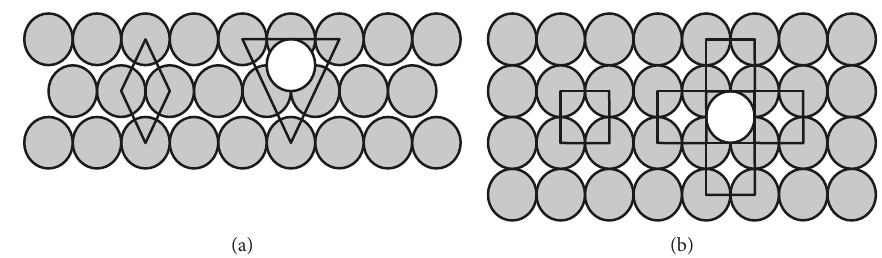
Figure 1: (a) Sulfur adsorption on fcc surfaces; (b) sulfur adsorption on a p (2 × 2) surface. Pd atoms are depicted in grey and S atoms in white.